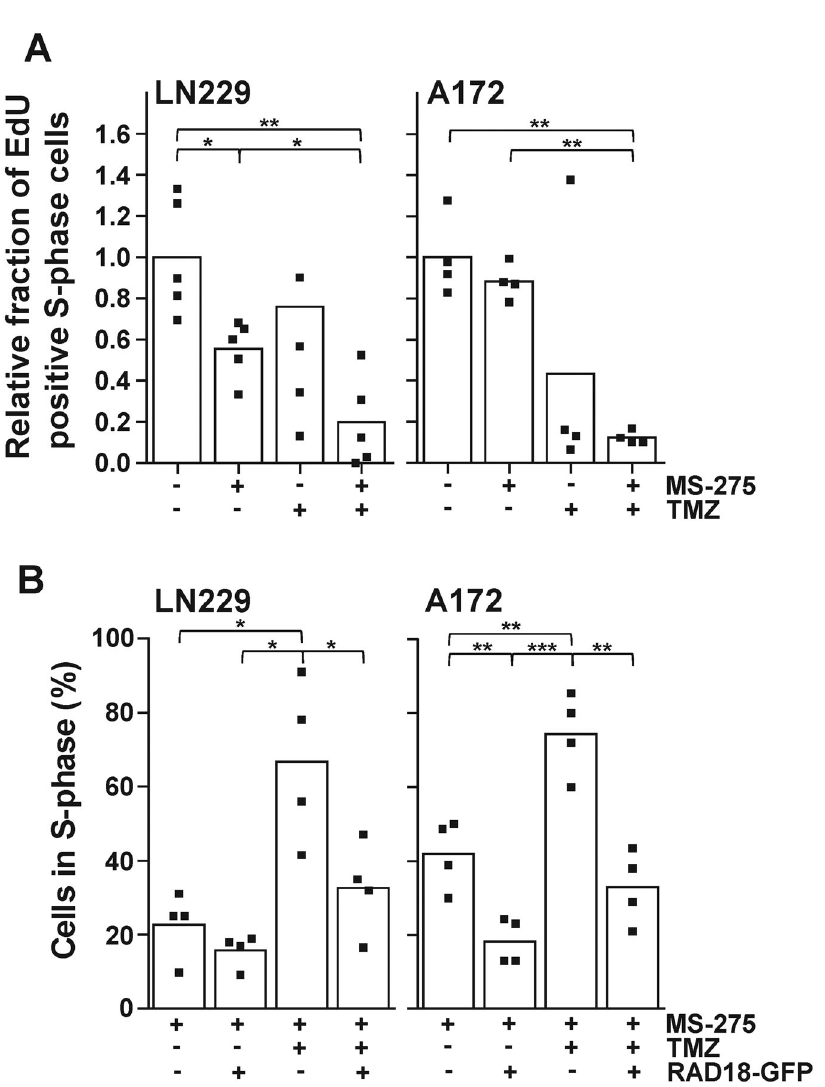
Fig. 5 Effect of RAD18 downregulation by MS-275 on DNA replication and cell cycle progression. A Quanti fi cation of EdU incorporation in LN229 and A172 cells exposed to indicated drugs. EdU incorporation and cell cycle distribution were determined by fl ow cytometric analysis. B Overexpressed RAD18 prevents TMZ-induced S-phase accumulation independent of MS-275. Cells were transiently transfected with RAD18- EGFP plasmid and cell cycle distribution was determined by Sub-G1 analysis 120 h after drug exposure. P ≤ 0.05; ** P ≤ 0.01 and *** P ≤ 0.001. Indicated signi fi cances result from an unpaired t -test with Welch ’ s correction. For A and B cells were exposed to MS-275 (1.5 µM), TMZ (50 µM) and TMZ/MS-275 and assays were performed 72 h and 120 h later,